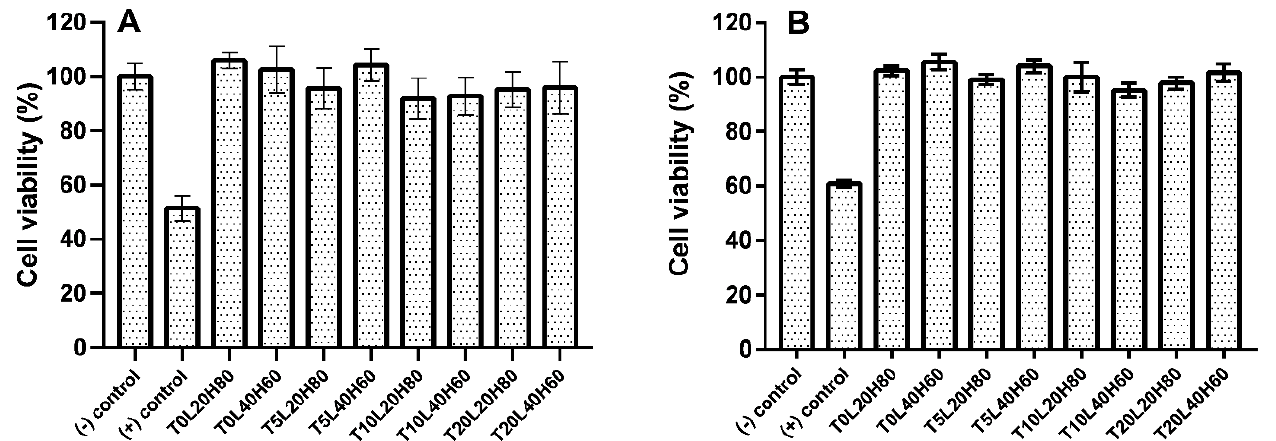
Figure 9. The cell viability of ARPE-19 cells by resazurin reduction assay after being treated with TA-loaded PCL implants: ( A ) indirect assay method and ( B ) direct assay method. Results represent means ± SD (n = 3).